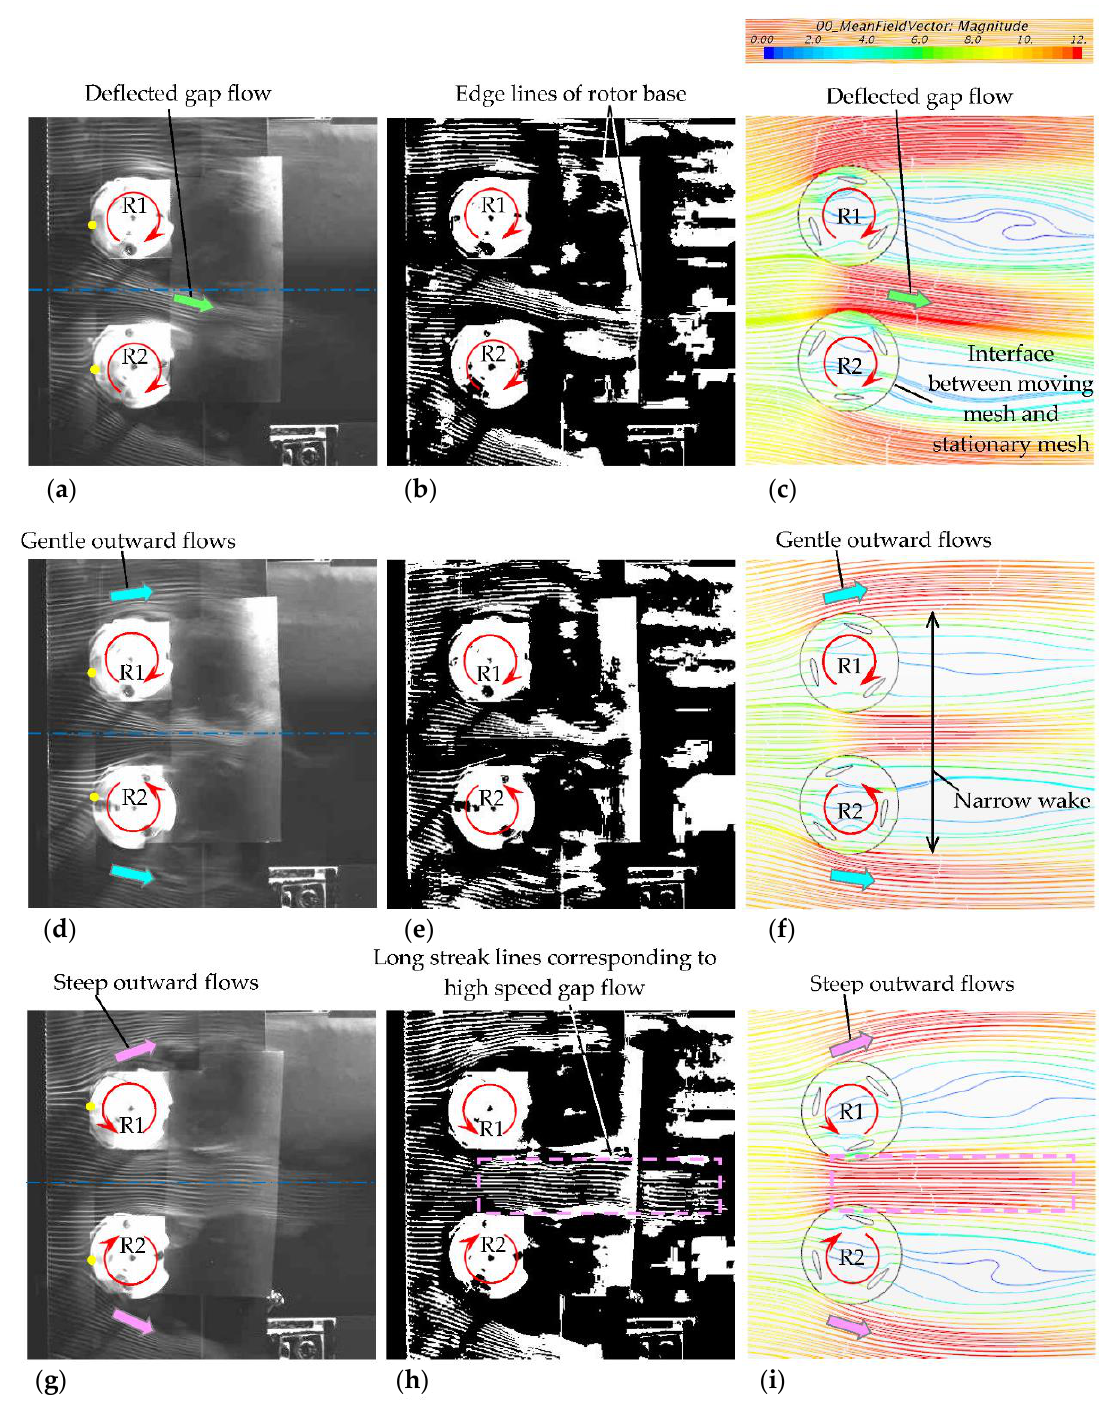
Figure 14. Photographs of smoke flow and the binarization images past two rotating turbines arranged side-by-side at g / D = 1.0 and t = 0.1 s under V = 2 m/s with corresponding CFD results (streamlines, V = 10 m/s): ( a – c ) CO; ( d – f ) CU; ( g – i ) CD.